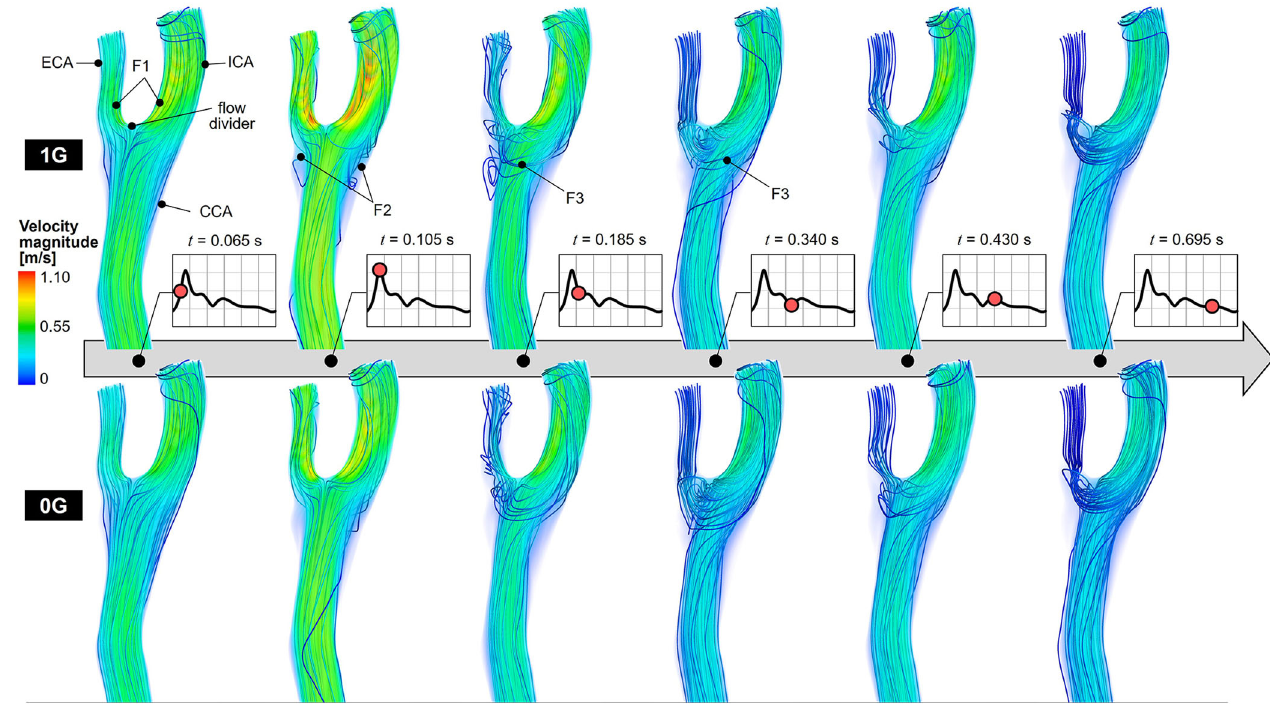
Fig. 1 Comparison of fl ow velocity magnitude volume rendering and streamline fi eld under 1G and 0G. The results are extracted from anatomy CB 3 and are shown at six phases of the cardiac cycle. The inset indicates the current time point as a red dot on the CCA mass fl ow rate waveform.